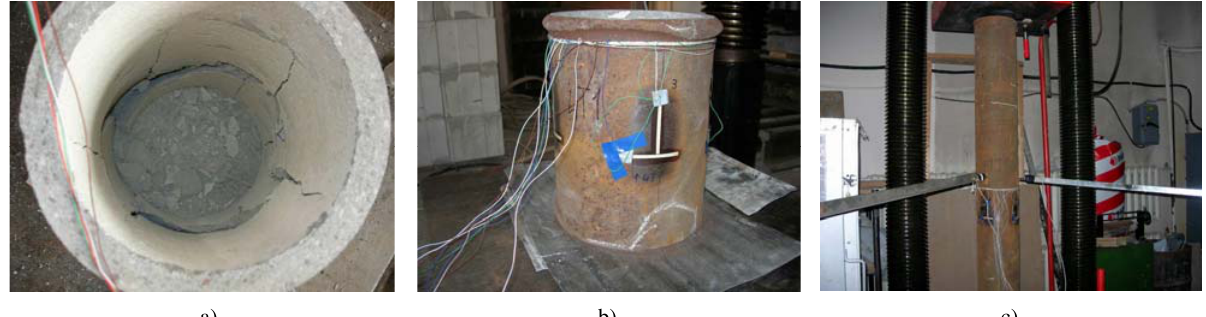
Fig 4 . Specimens tested under ambient conditions: a) HC-type specimen after testing; b) short HC-FST-type specimen